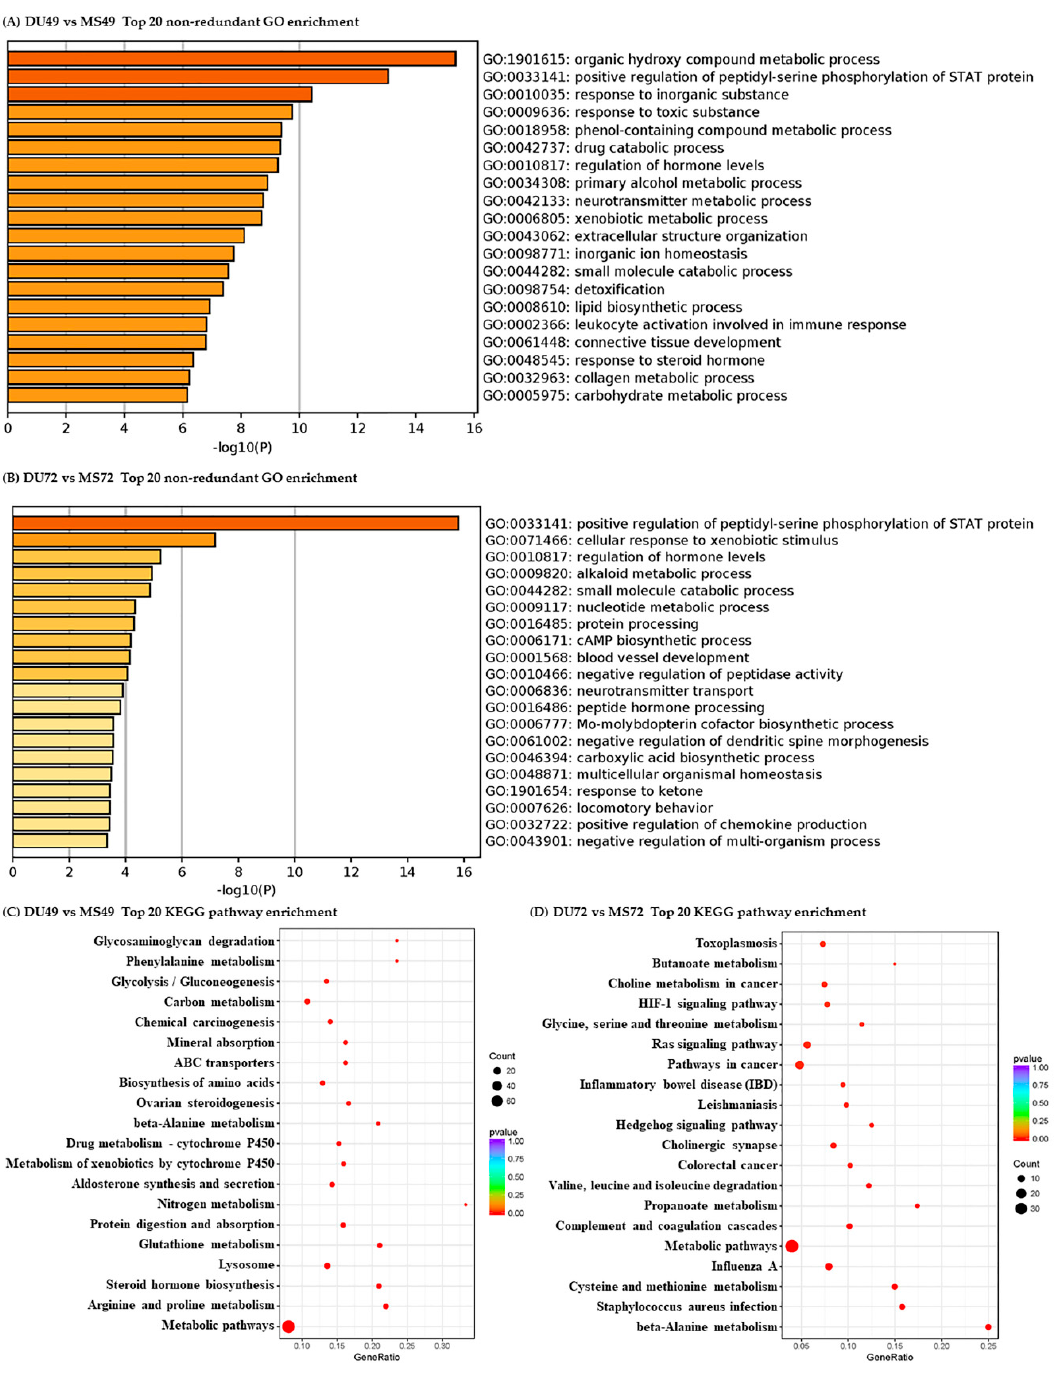
Figure 3. Pathways clustered from DEGs detected between Duroc and Meishan sows. Top 20 non- non-redundant enriched GO terms ( A , B ) and top 20 KEGG pathways ( C , D redundant enriched GO terms ( A , B ) and top 20 KEGG pathways ( C , D ).